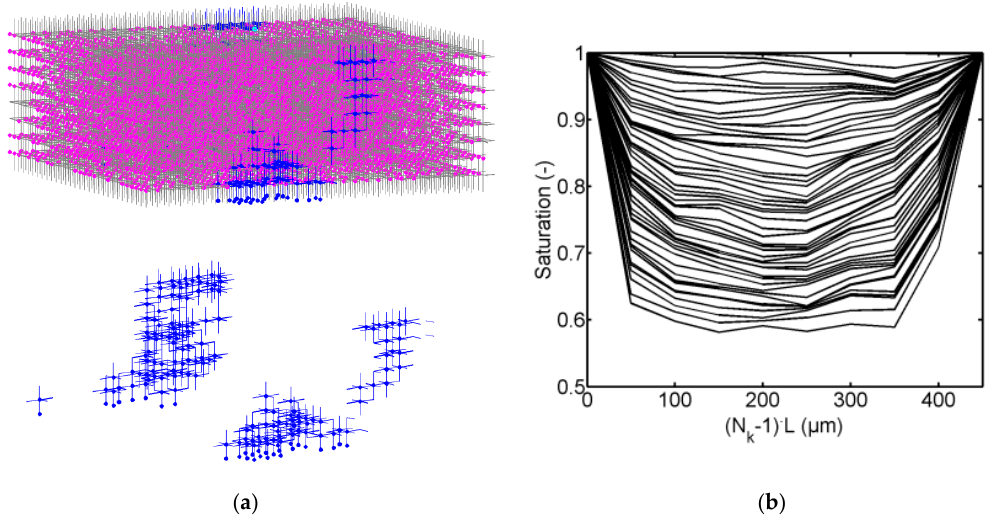
Figure 12. ( a ) PN invasion from one surface pore (shown is the complete PN with gas phase in white, disconnected clusters in grey, and the liquid transporting cluster at the breakthrough of the gas phase in blue). ( b ) Saturation profiles for S = [1:0.64].